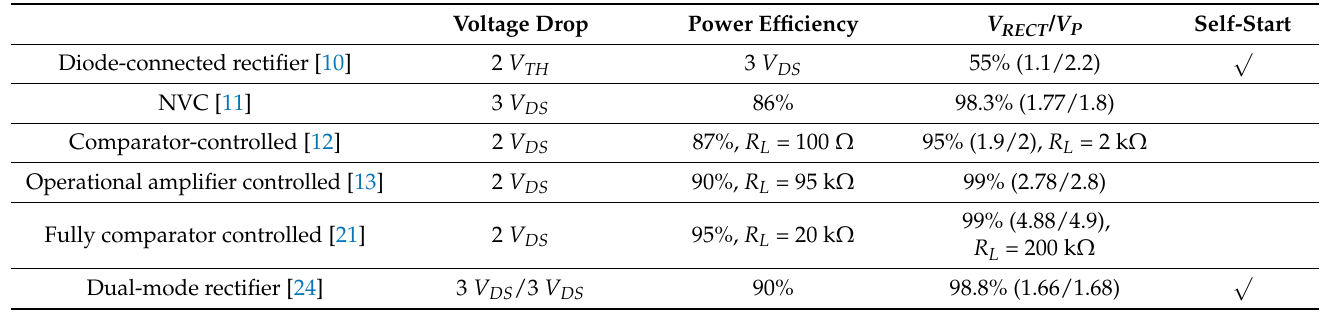
Table 2. Comparison for different implementation of the rectifier. Voltage